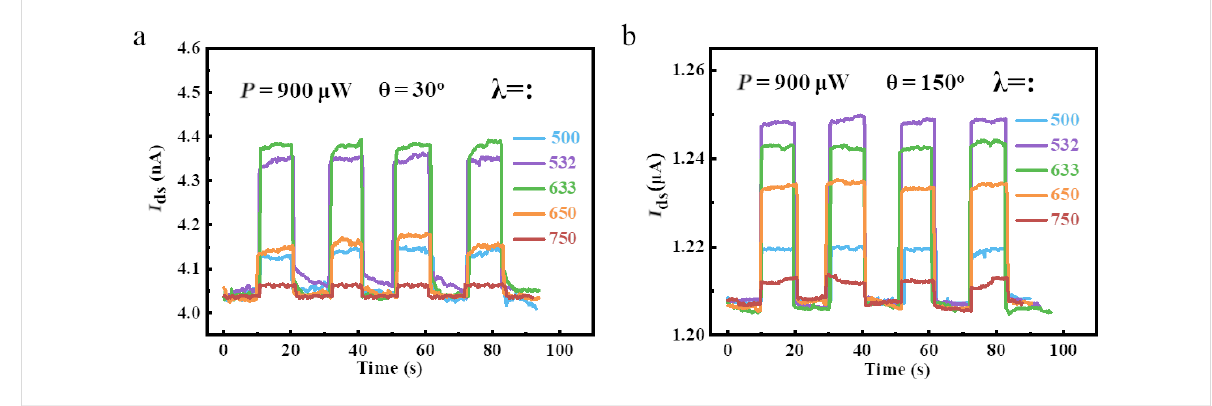
Figure 6: Wavelength-resolved photocurrent response of the photodetector fabricated with 1T’-WTe 2 . a,b) The real-time and photocurrent response of different test angles at 30° and 150°, with incident wavelength variation from 500 to 750 nm.